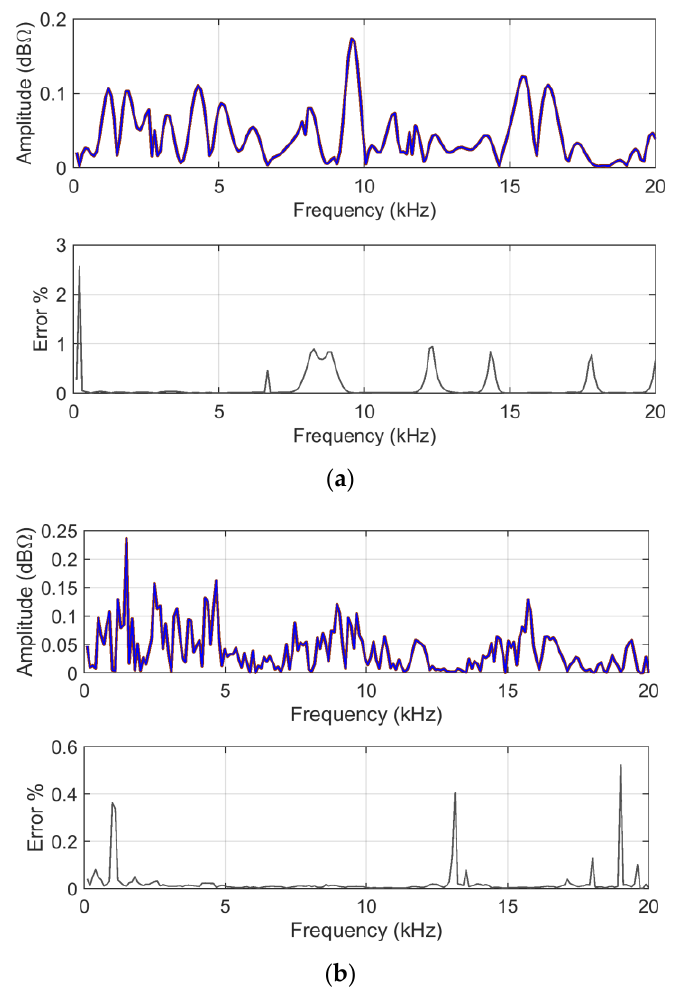
Figure 8. Z (47.5 km) and Z (48.0 km) input data in logarithmic scale: ( a ) ADM i and ( b ) FDM i plots as provided by analytical calculation (blue) and mean of MCM output (brown); blue and brown curves are overlapped with underlying brown curve visible at the edges of the blue one. The relative error has increased to a fraction of % or a few % at some points, where the ADM i or FDM i values are the lowest; on average, correspondence between analytical and MCM curves is quite good.